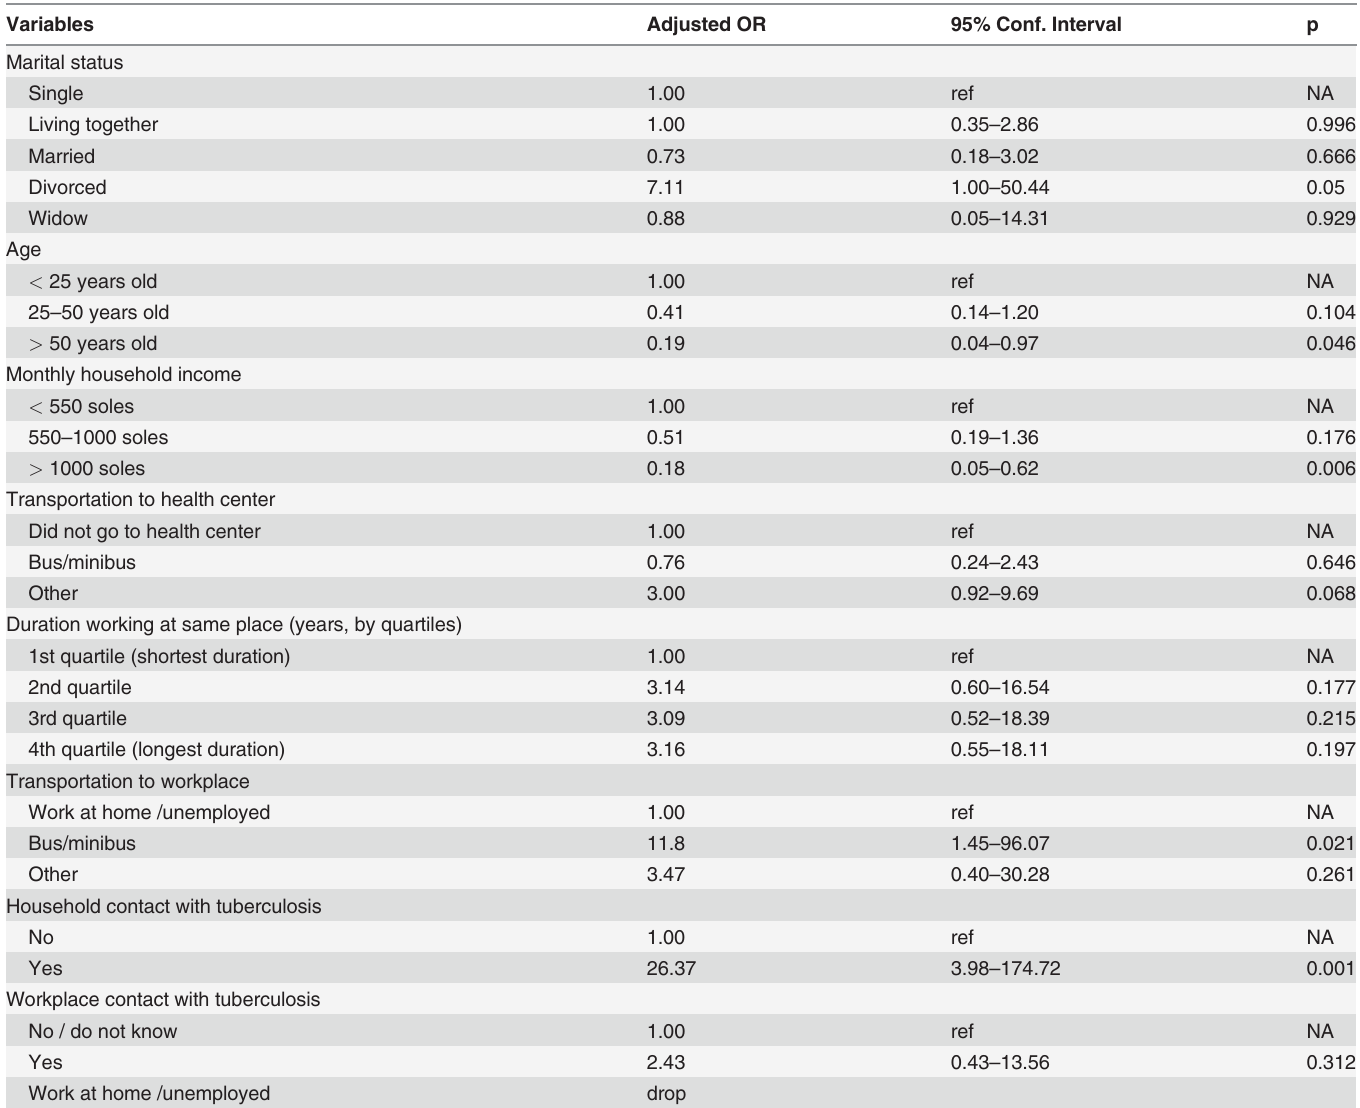
Table 2. Multivariate assessment of risk factors for